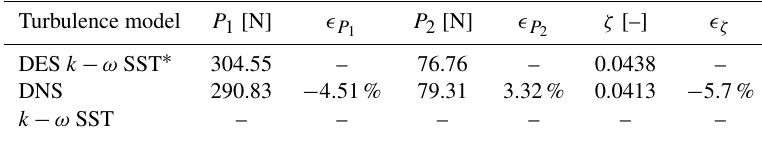
Table A3. Comparison of peaks and damping ratios for different turbulence